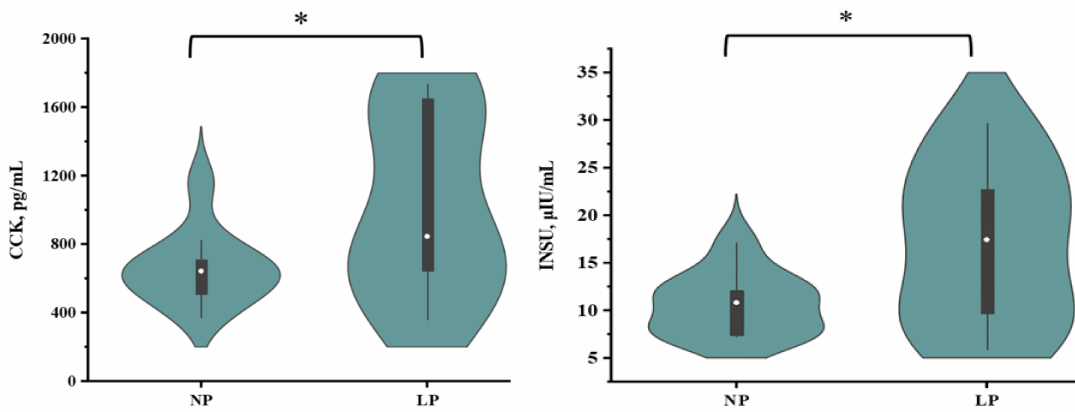
Figure 3. Plasma CCK and Insulin concentrations in goats fed a low-protein diet. On each side of the gray line is a kernel density estimation to illustrate the distribution of shape of the data in a group. Wider and skinnier sections of the violin plot represent a higher and lower probability. The white dot represents the median and the thick gray bar in the center represents the interquartile range. * = significantly different means ( p <